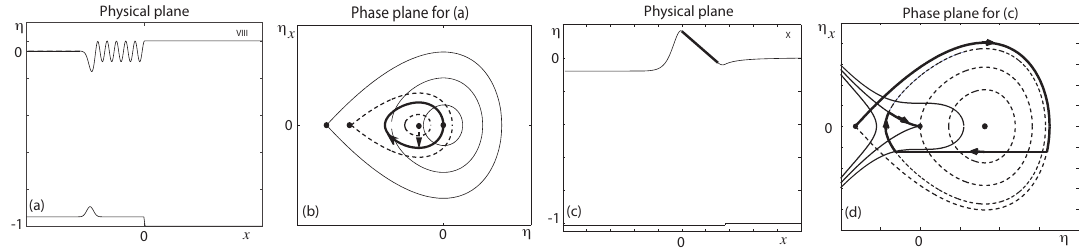
Figure 10. Hybrid flows. ( a , b ) Flow type VIII past a bump on a step, F < 1, F u < 1, h > 0 and A > 0. ( c , d ) Flow type X past a flat plate and step down, F = 1, F u > 1, h < 0 and L > 0 [33].